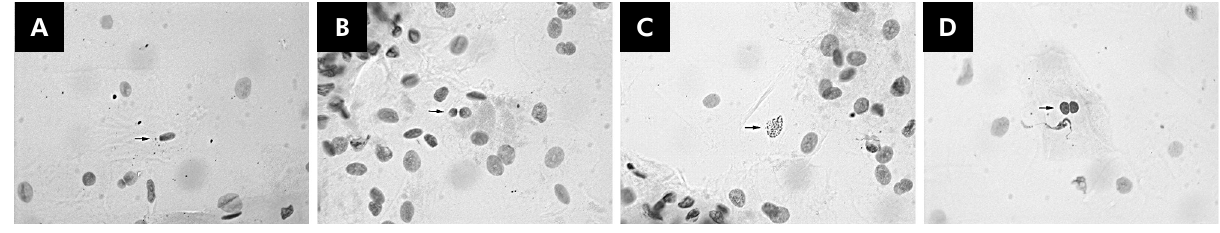
Figure. Cytogenetic abnormalities of oral mucosal cells exposed to cell phone radiation. A: micronuclei; B: broken egg; C: karyorrhexis; D: binucleated cell. Bar, 10 µm (Feulgen stain, original magnification 1000x, under oil